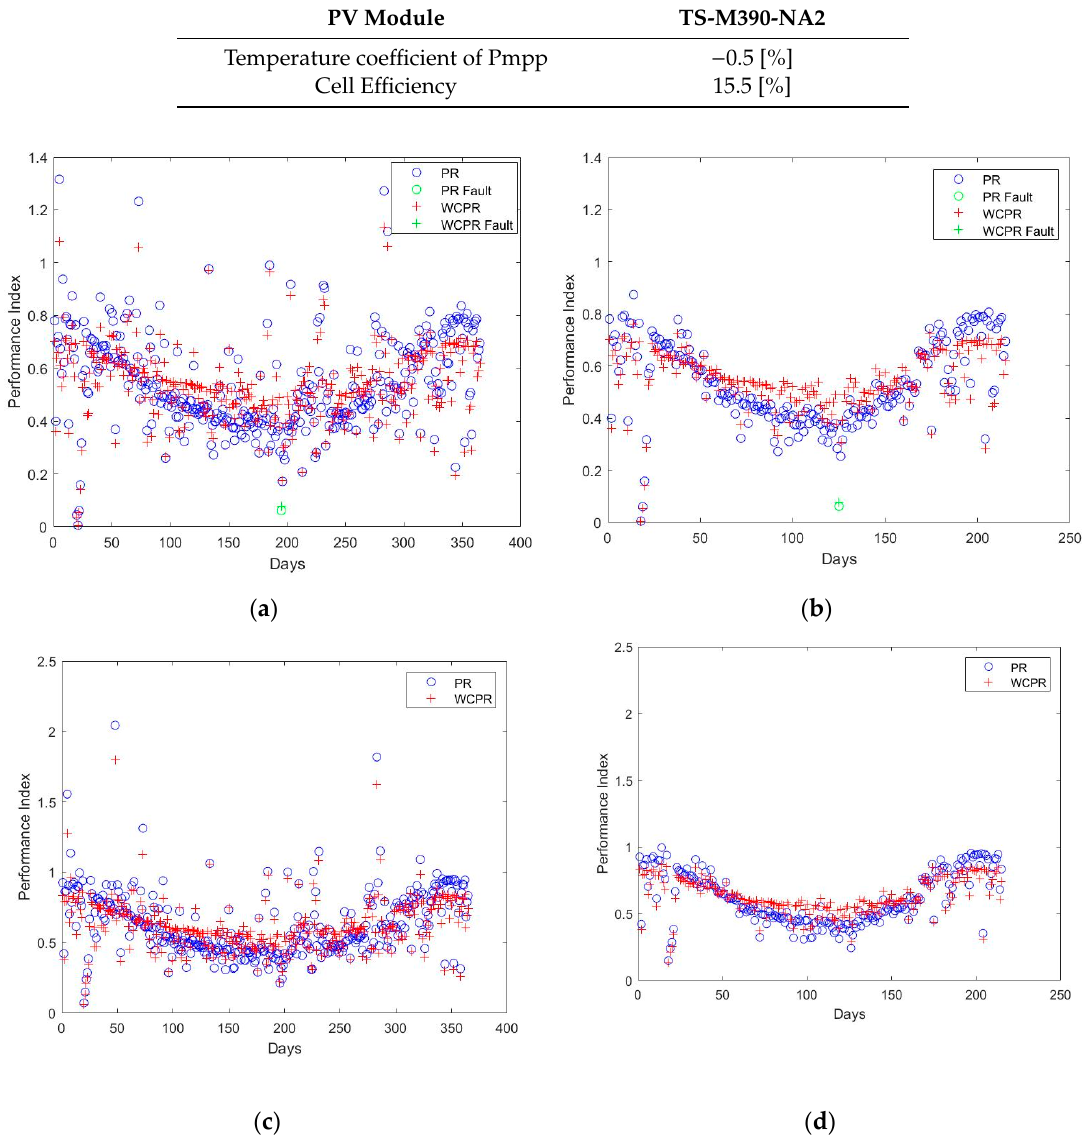
Figure 1. The Performance Ratio (PR) and Weather-Corrected Performance Ratio (WCPR) of each plant and their conditions. ( a ) Plant A (2 MW); ( b ) Plant A (2 MW)—CI > 0.5; ( c ) Plant B (2.3 MW); ( d ) Plant B—CI > 0.5.